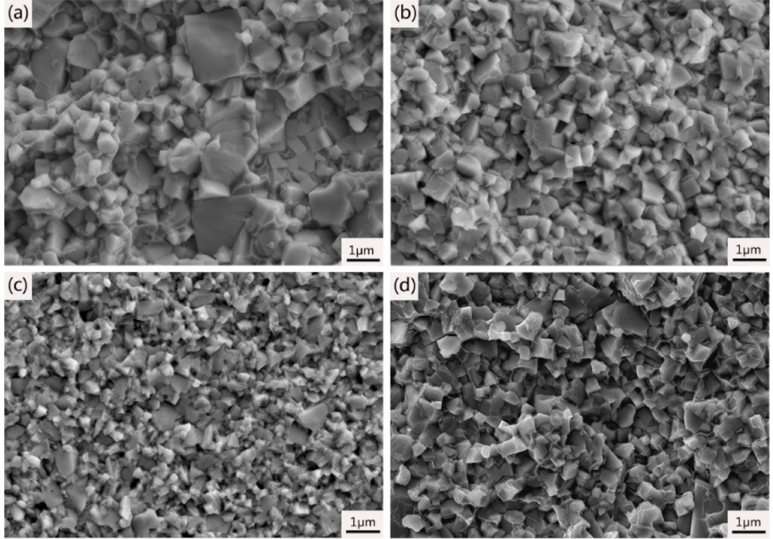
Figure 14. The fracture surface morphologies of WC–10 wt. % Co sintered cemented carbides. ( a ) WC–10Co; ( b ) WC–10Co–0.8Cr 3 C 2 ; ( c ) WC–10Co–0.8VC; ( d )